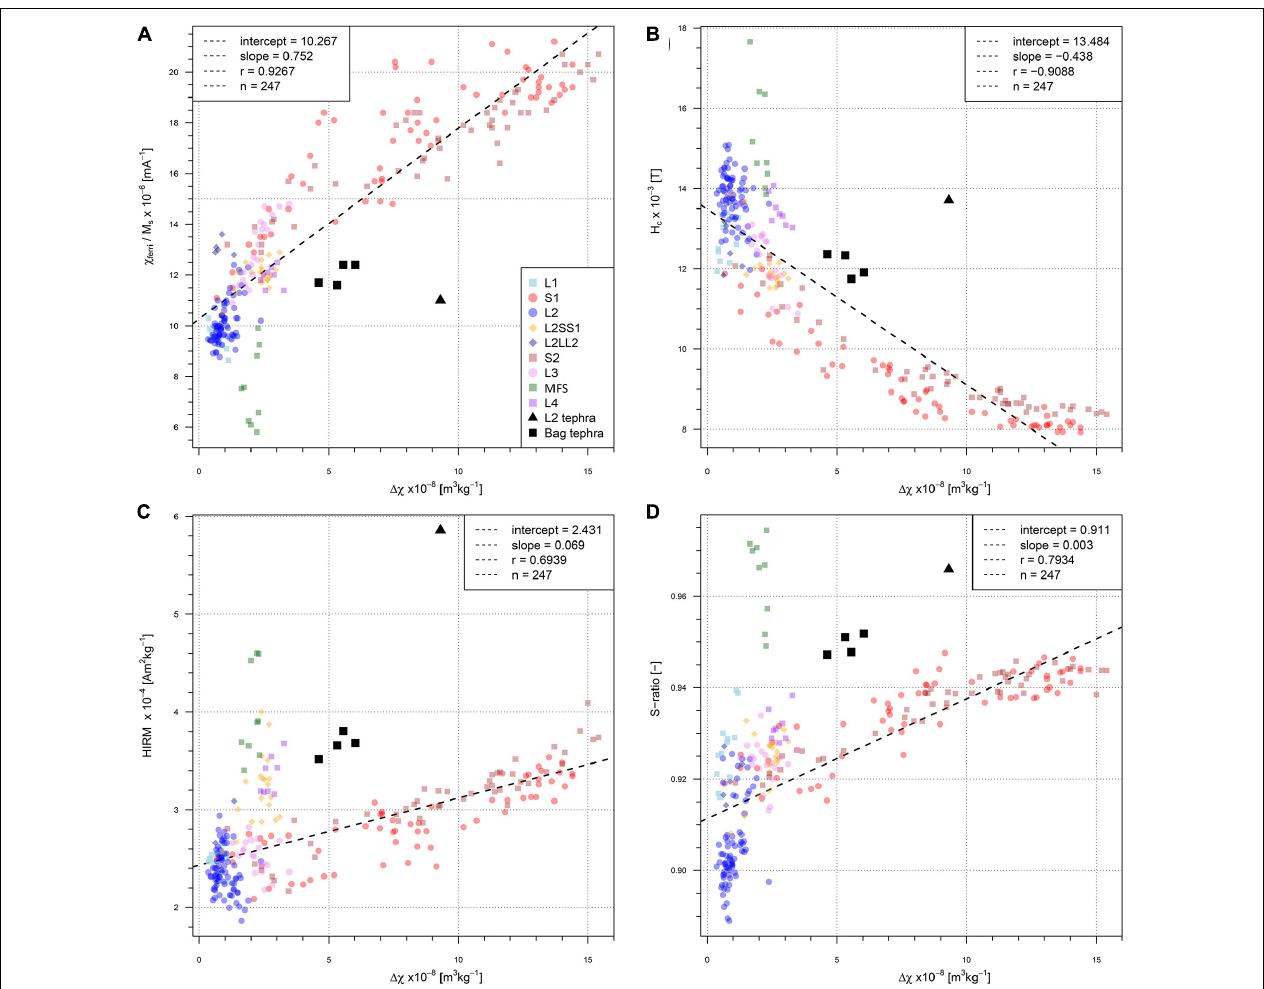
FIGURE 4 | Correlation of different magnetic parameters [ χ ferri /Ms, (A) ; Hc, (B) ; HIRM, (C) ; and S-ratio, (D) ] and inter-parametric ratios compared to (cid:49) χ for the units and samples summarized in Table 3 . For correlation coefficients and regression fits, samples from the MFS, and the tephra layers were